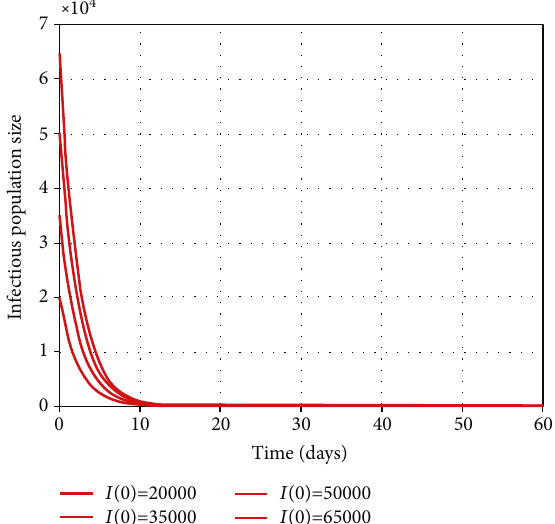
Figure 6: The time series plot of the infectious